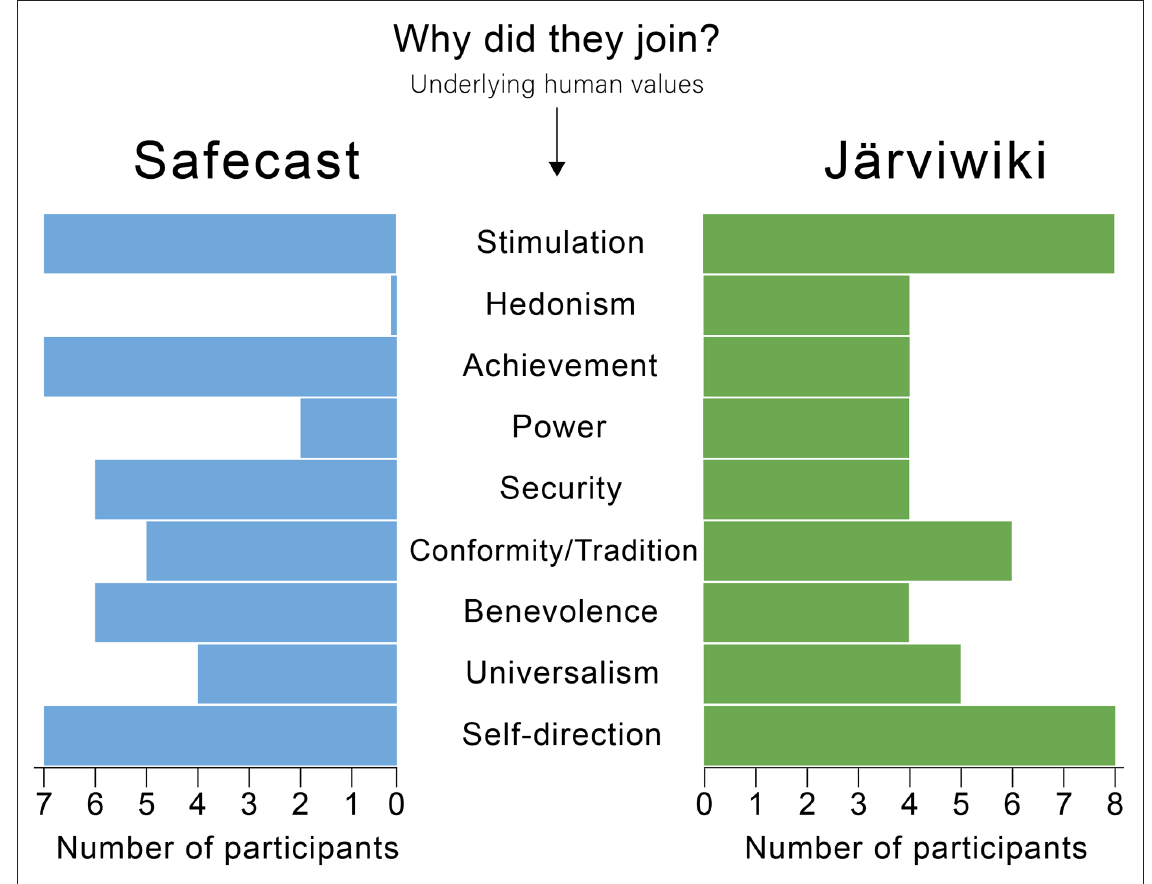
Figure 7: Values underlying initial participation among Safecast and Järviwiki